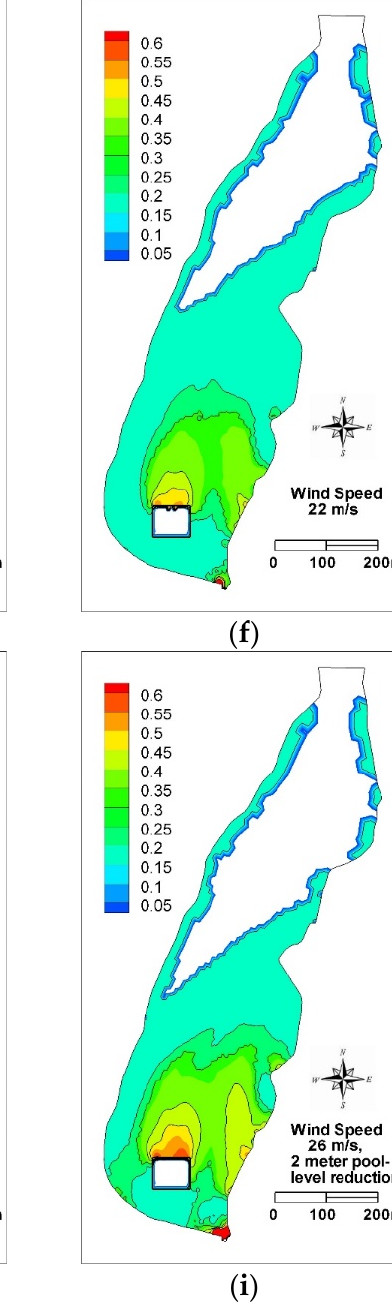
Figure 7. Ice thickness expansion on the reservoir surface domain at different northerly wind speed, and ( a – h ) for lowering the damming level by 1 m and ( i ) for reduction of the pool level by 2 m.